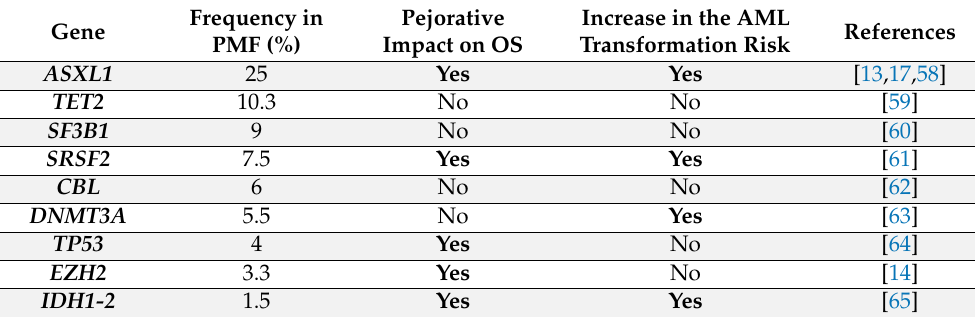
Table 2. Prognostic impact of additional mutations described in PMF.